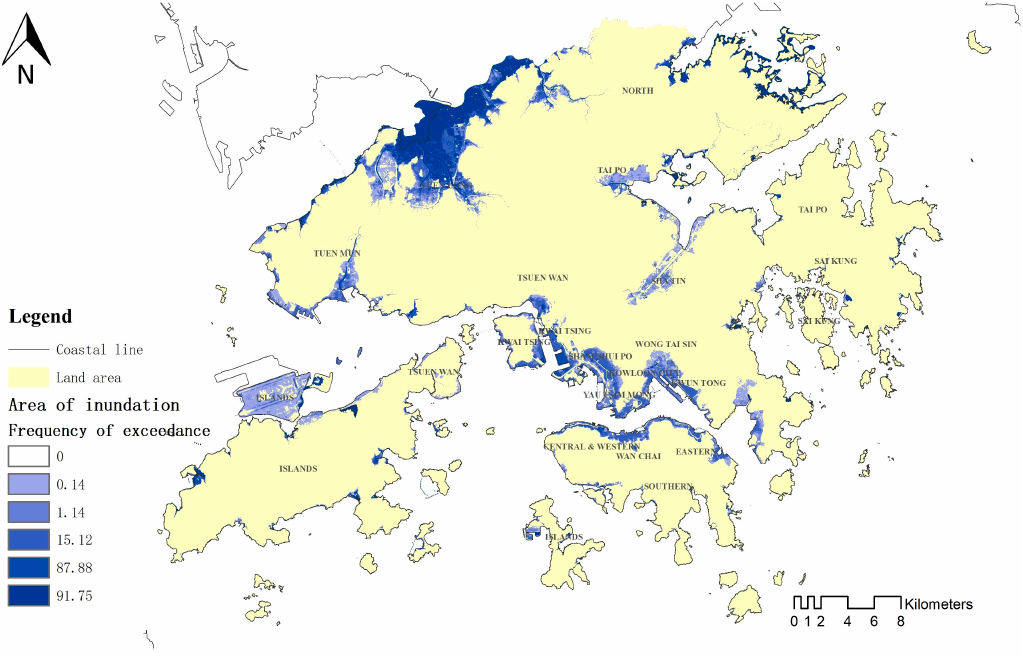
Figure 4. Coastal flooding exposure map under SSP 8.5.